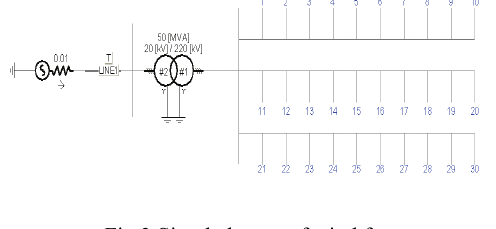
Fig.3 Simple layout of wind